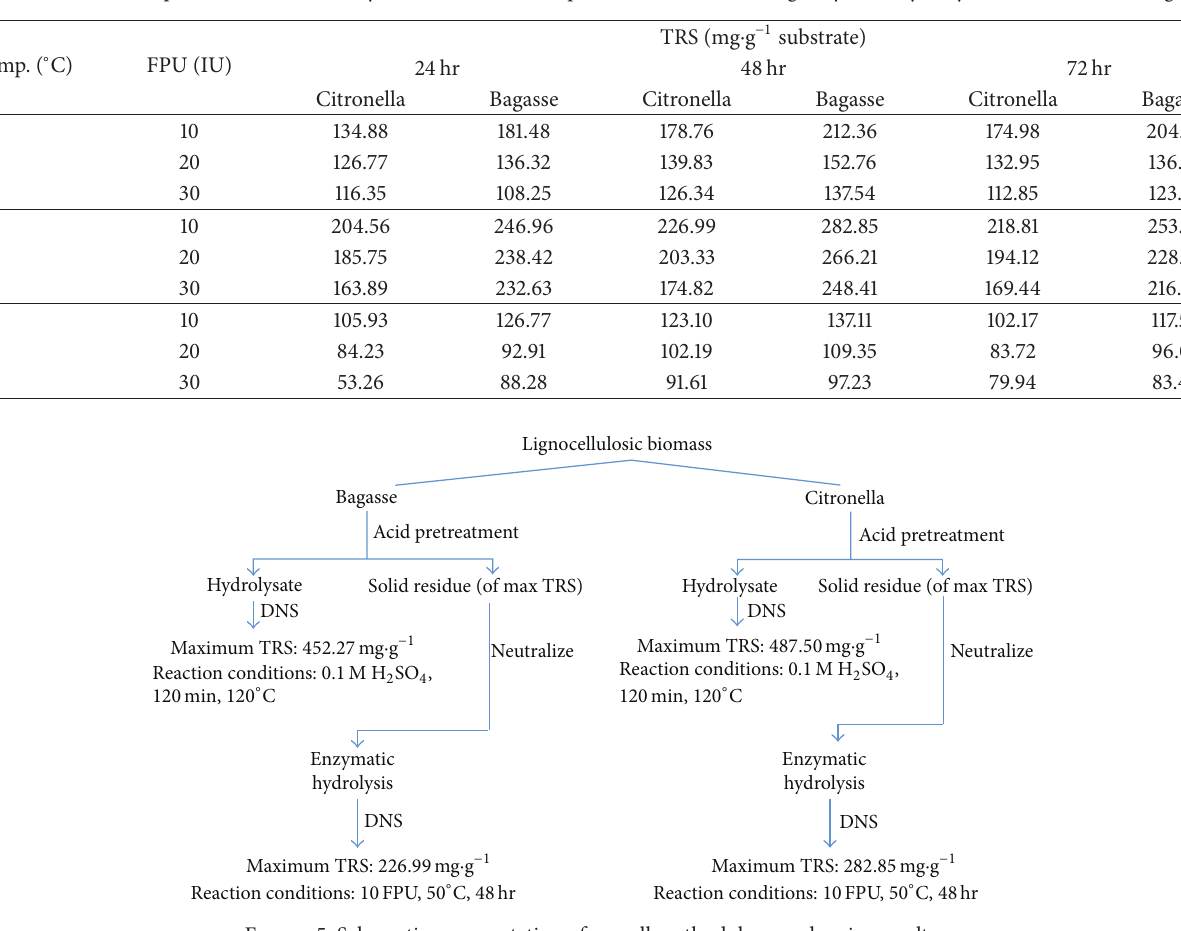
Figure 5: Schematic representation of overall methodology and major